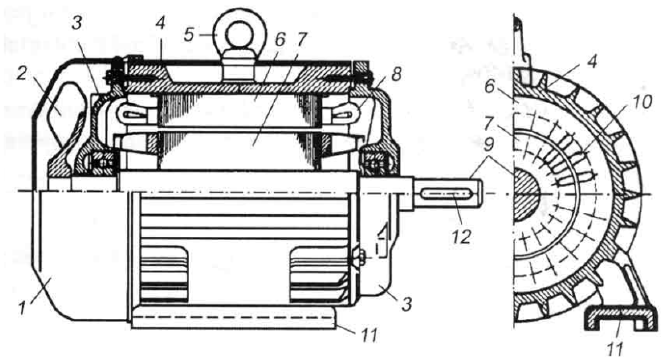
Figure 1. Asynchronous motor (1—fan cover, 2—fan, 3—bearing shield, 4—stator frame, 5—suspension eye, 6—stator sheets, 7—rotor sheets, 8—stator winding, 9—shaft, 10—stator winding slots, 11—mounting foot, 12—wedge slot) [1] .